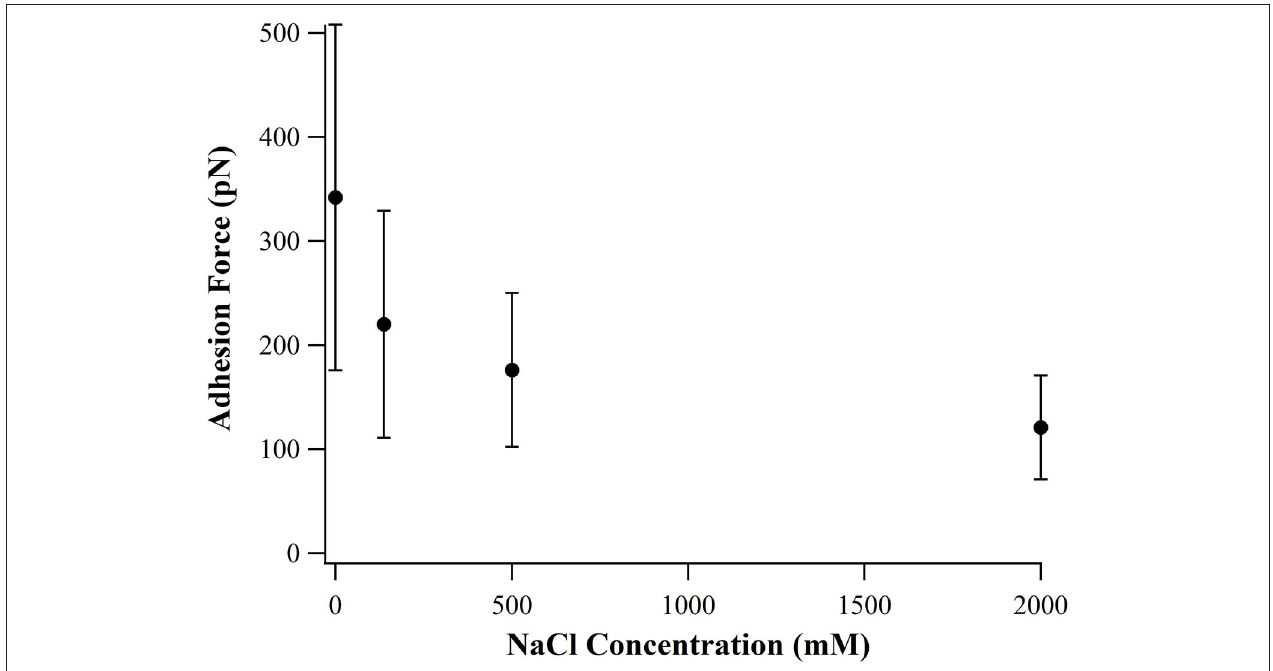
FIGURE 4 | Adhesion force of SB7 at different concentration of NaCl (pulling speed of 10